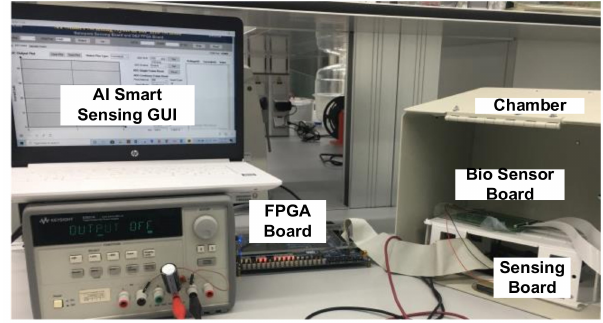
Figure 18. Measurement setup on Board with